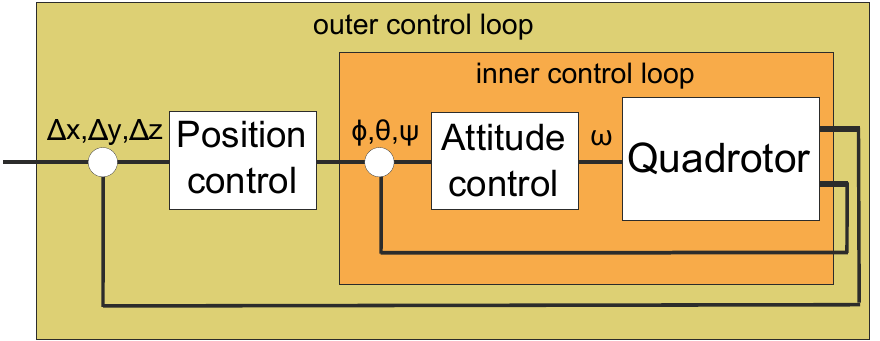
Figure 2. Nested low-level control loop: attitude and position